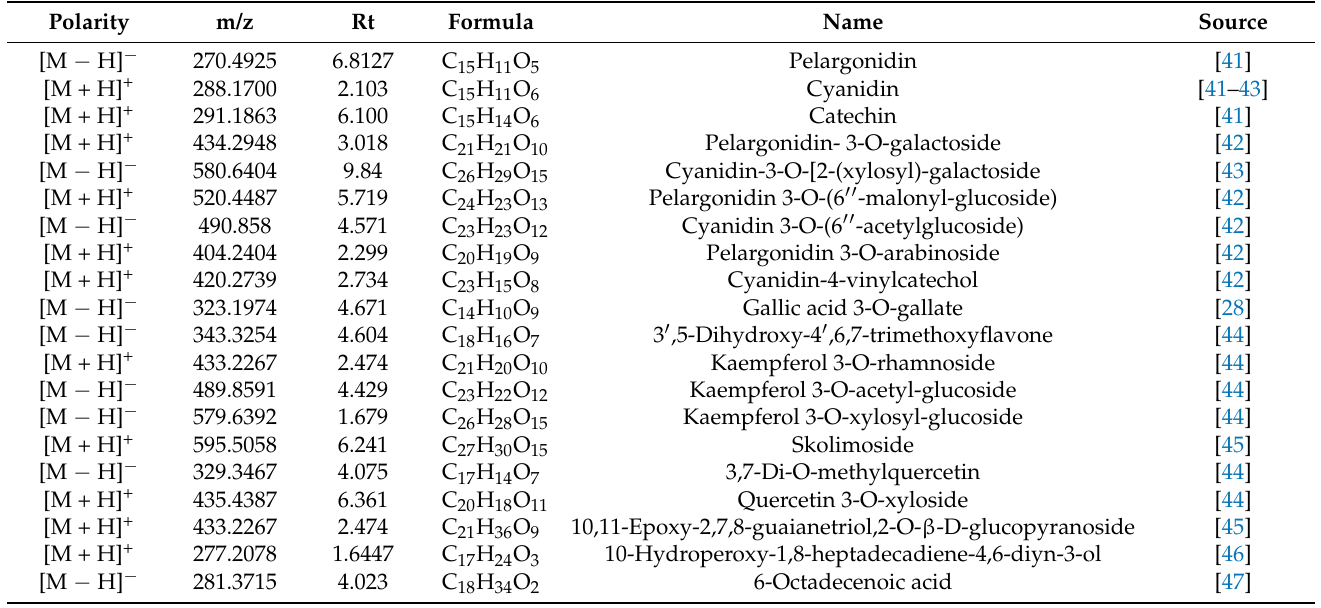
Table 1. Annotated compounds by LC–MS metabolomic analysis of the red carrot methanolic extract.